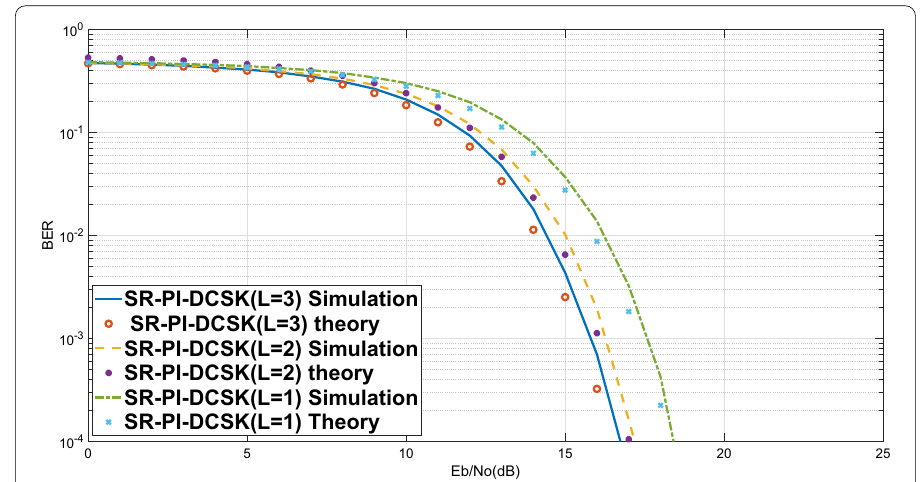
Fig. 14 Theoretical and simulation bit error performance for SR‑PI‑DCSK for different frame lengths for β = 300 . Simulation results are depicted by lines while theoretical results are depicted by markers